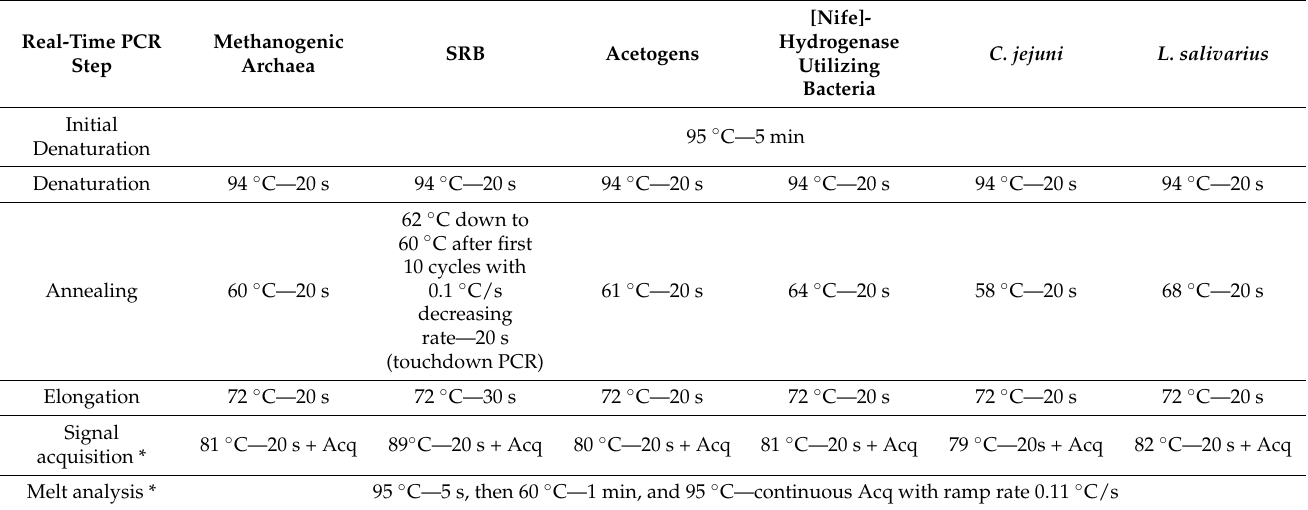
Table 7. Temperature settings and DNA standards used for the absolute quantification of each group of